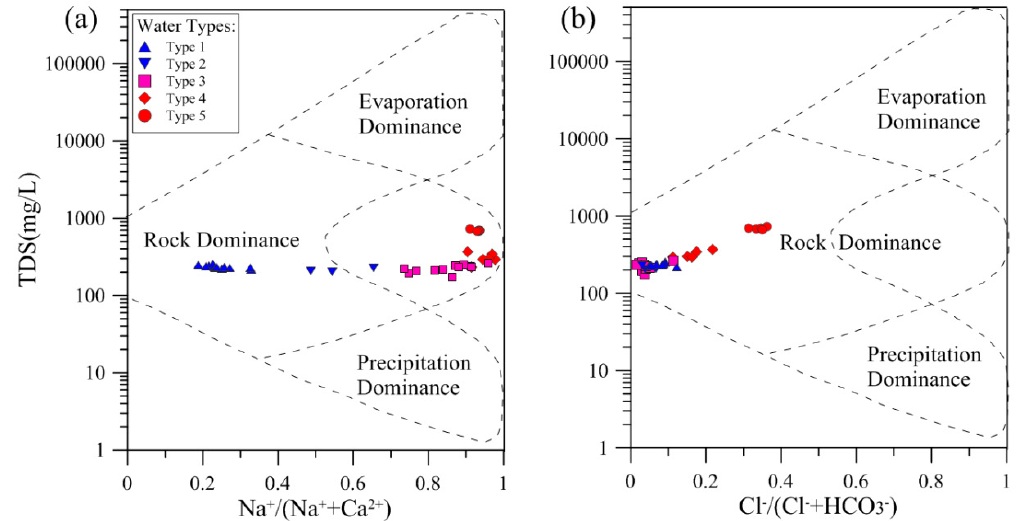
Figure 8. The Gibbs diagram for groundwater in the study area: ( a ) logTDS vs. Na + / (Na + + Ca 2 + ) and ( b ) logTDS vs. Cl − / (Cl − + HCO 3 − ).